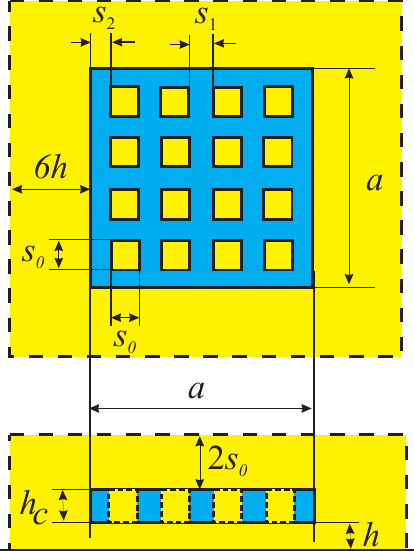
Figure 4 . Structure of simulated dampers. Topology with N = 16 holes is shown. The fi gure also illustrates the simulation space around the structure in 3D N-S simulations. Here the width of the outer frame s is set equal to the separation of holes s 2 1